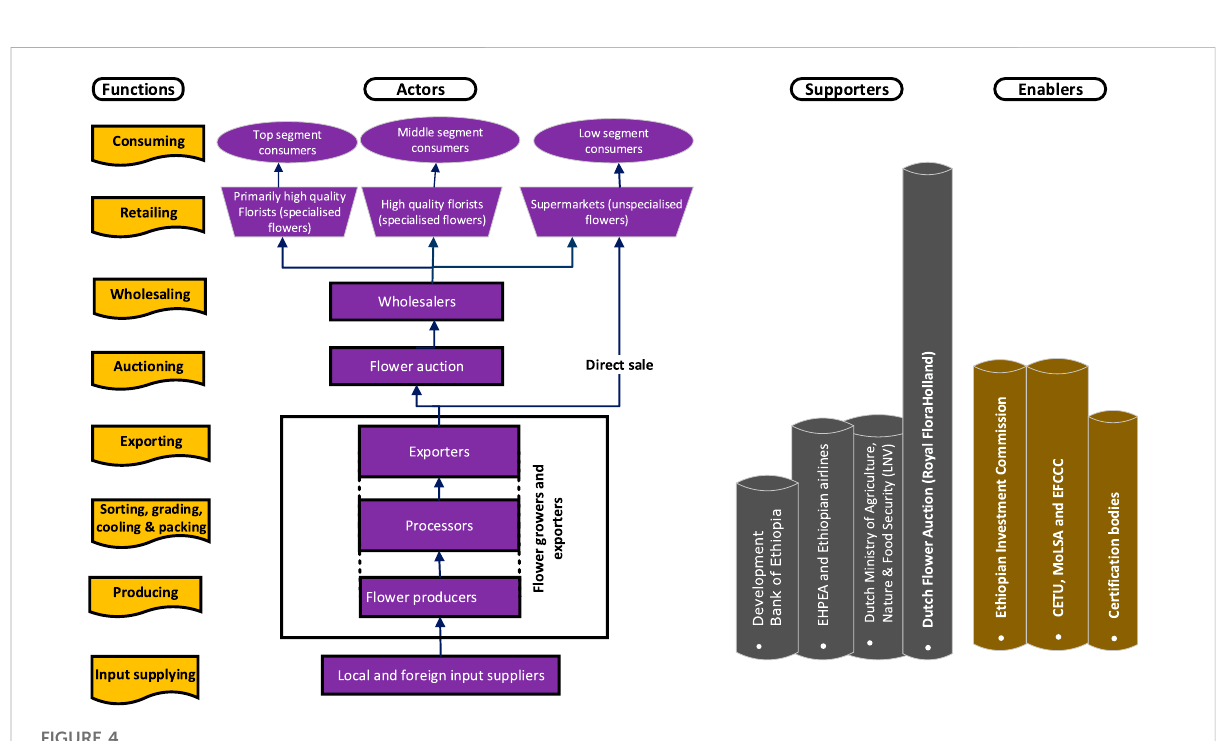
FIGURE 4 Value chain map of Ethiopian fl owers in Europe. Mebrat,